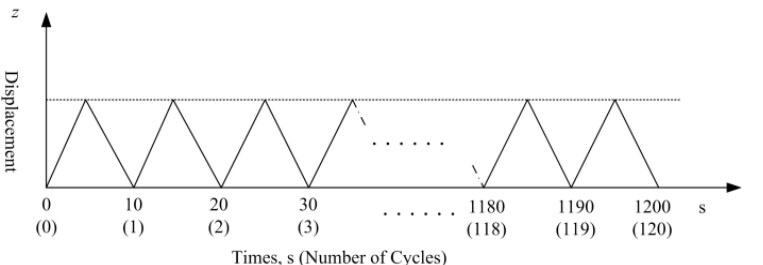
Figure 4. Schematic of test sequence. Note: At a maximum crack opening of 0.2 mm, the total number of cycles is